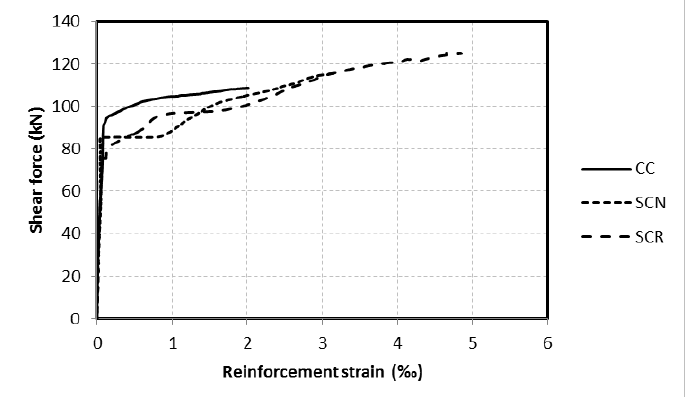
Figure 5. Reinforcement strain measured during loading.